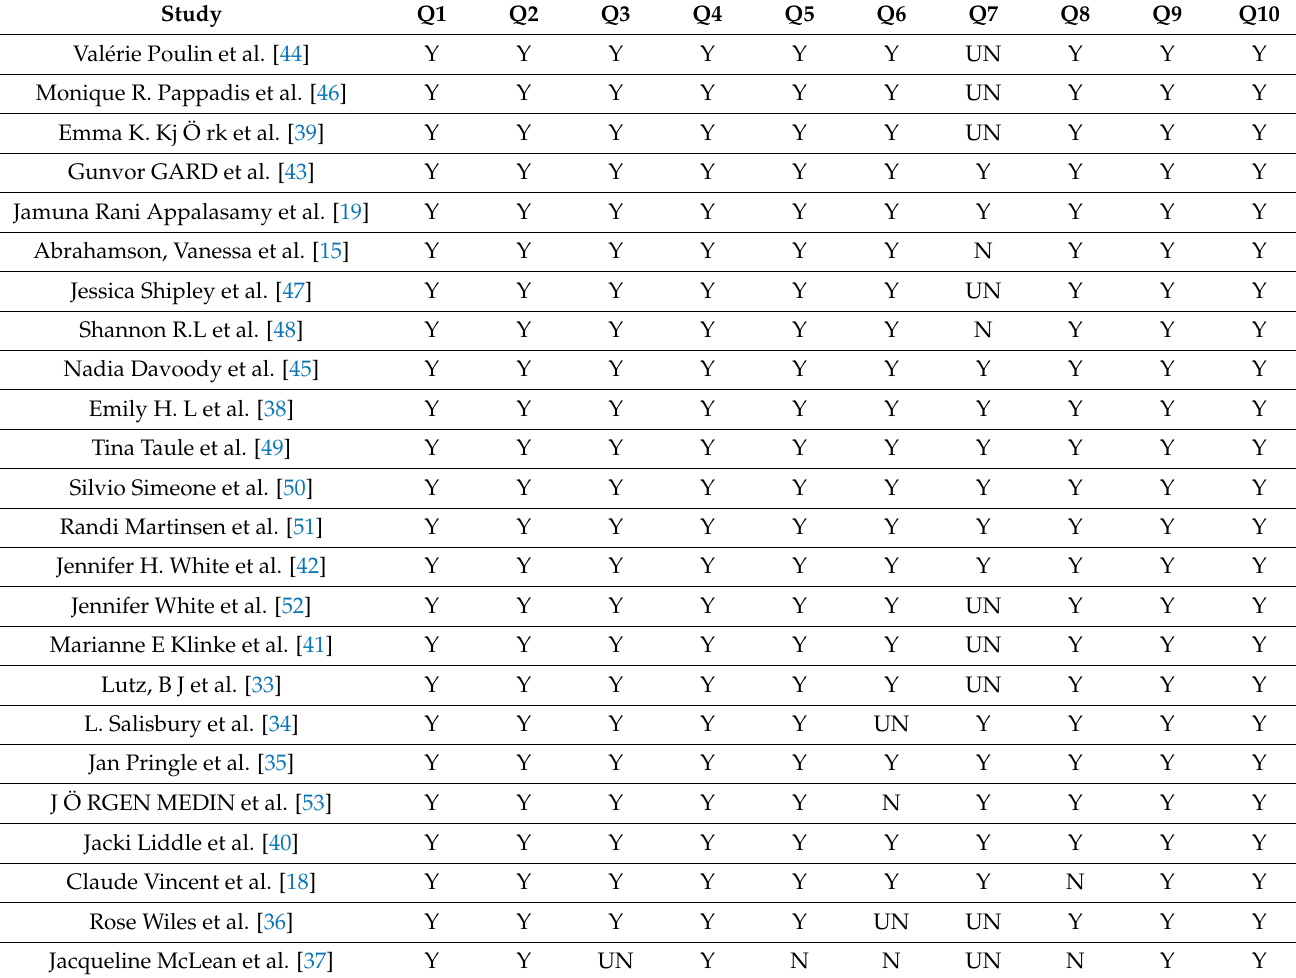
Table 2. Quality Assessment of Involved studies (N =